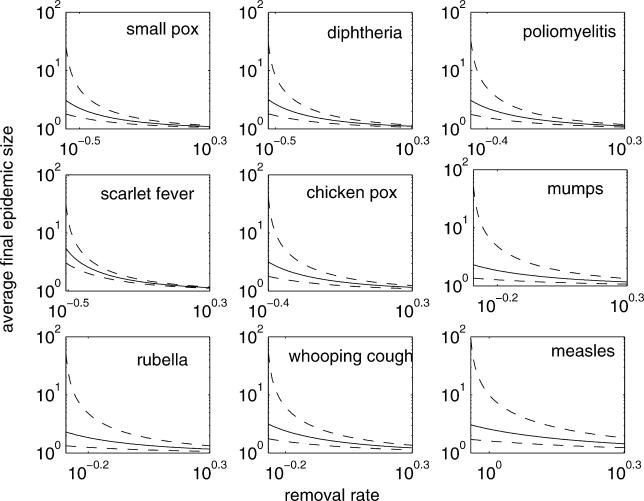
Expected Final Outbreak Size for Nine Directly Transmitted Diseases as a Function of the Removal RateThe expected final outbreak size (y-axis) for nine directly transmitted diseases is represented as a function of the removal rate (x-axis). Estimates are bounded by minimum and maximum estimates (dashed lines) of the contact rate β based on published estimates of R
0.